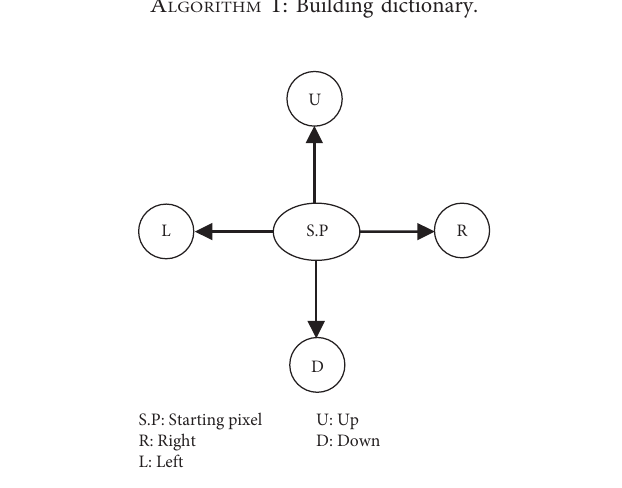
Figure 4: Four freeman chain code